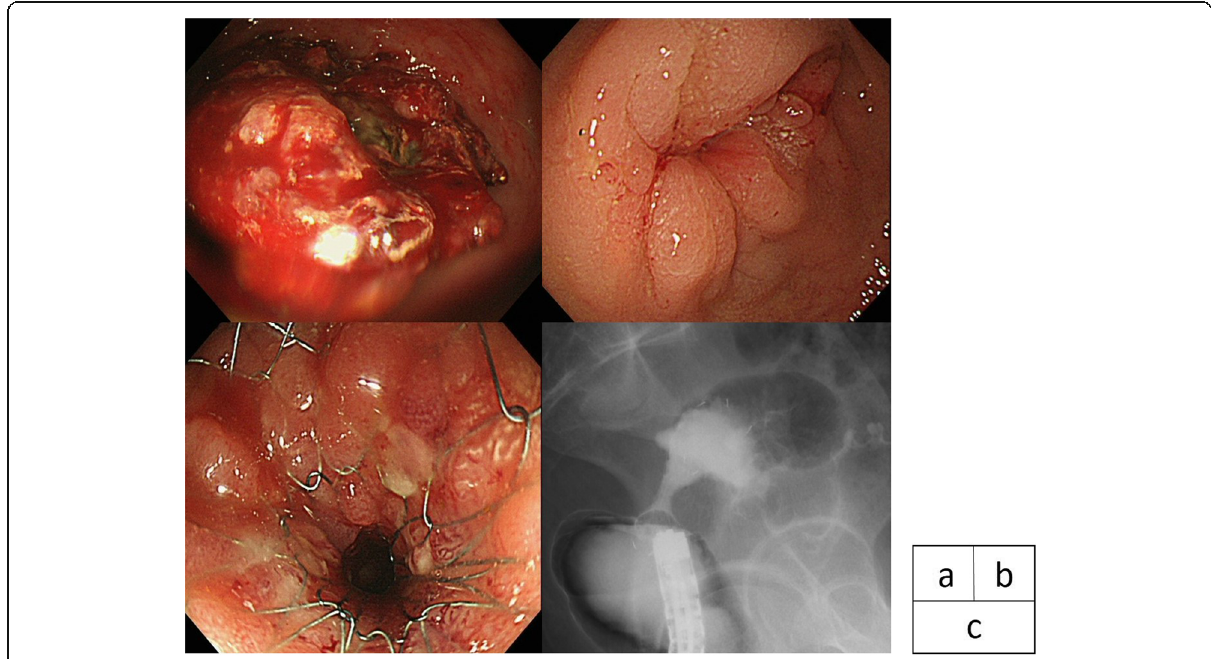
Fig. 4 a Colonoscopy findings. Colonoscopic examination revealed a circumferential tumor in the lower rectum, 45 mm from the anal verge. b Colonoscopy findings. The shape of the stenosis was smooth and edematous that seemed to have been caused by a good response to NAT. c . Stent placement. A Niti-S Colonic Stent, 6 cm in length by 18 mm in diameter, was placed across the obstruction as a